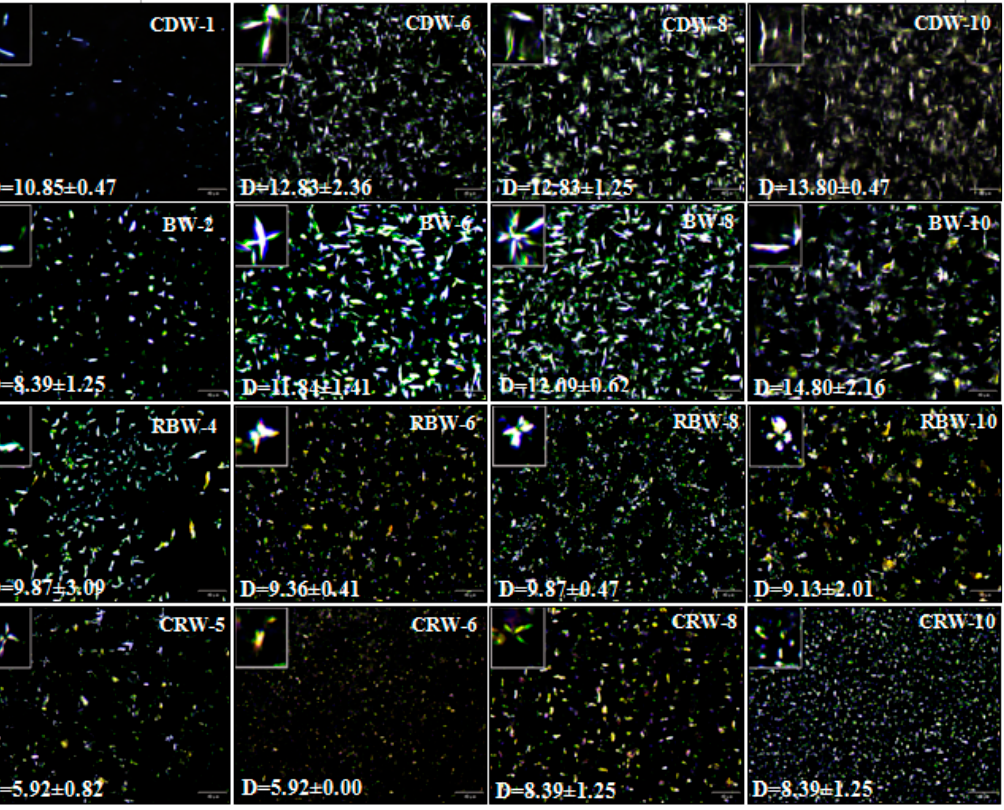
Figure 2. Polarized micrographs of oleogels prepared using CDW, BW, RBW, and CRW at critical concentration and 6, 8, 10 wt.% (25 °C). concentration and 6, 8, 10 wt.% (25 ◦